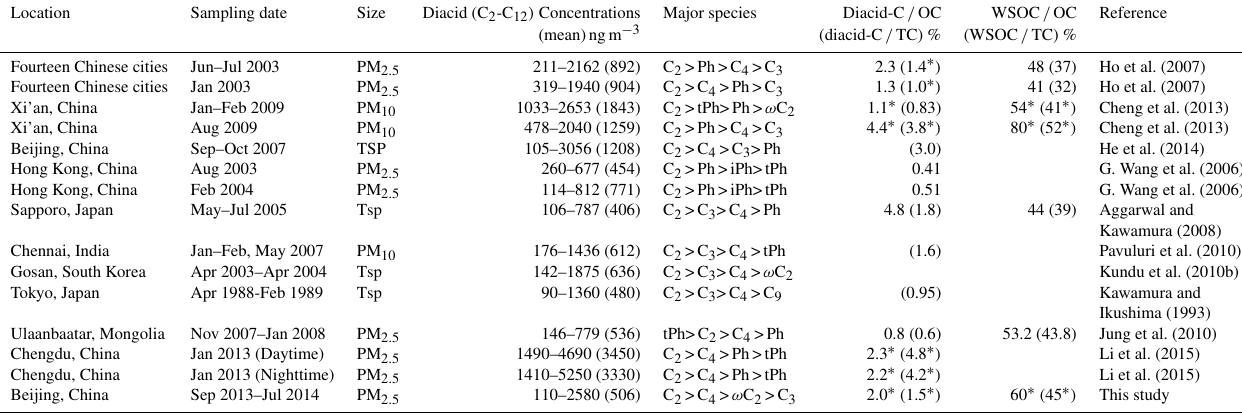
Table 2. A comparison of diacids at the Beijing site and other areas detected in previous studies. Location